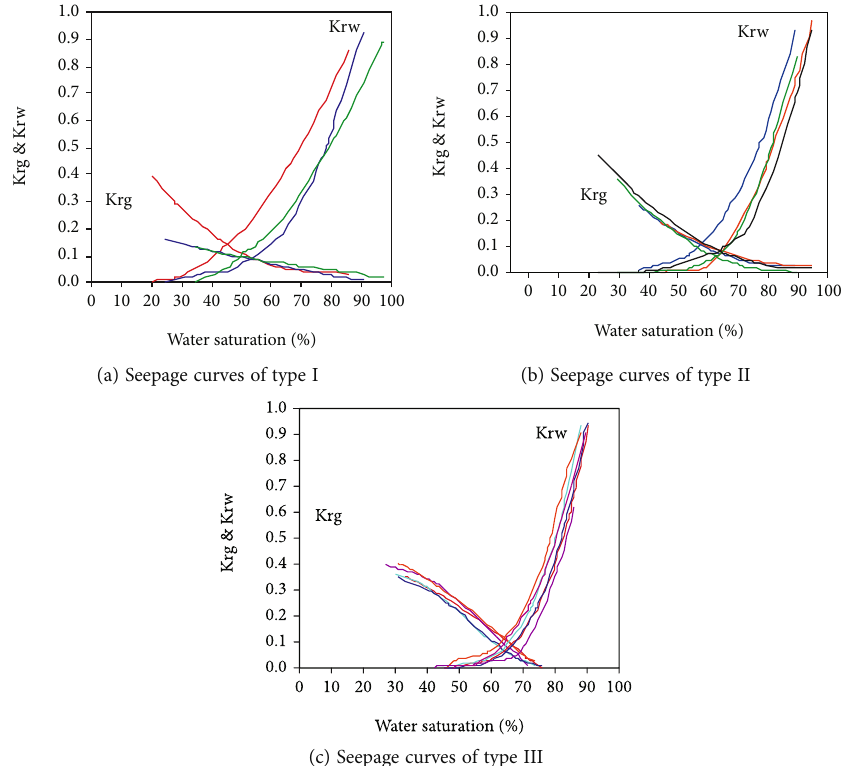
Figure 6: Three kinds of seepage curves in He8. (a) Seepage curves of type I. (b) Seepage curves of type II. (c) Seepage curves of type